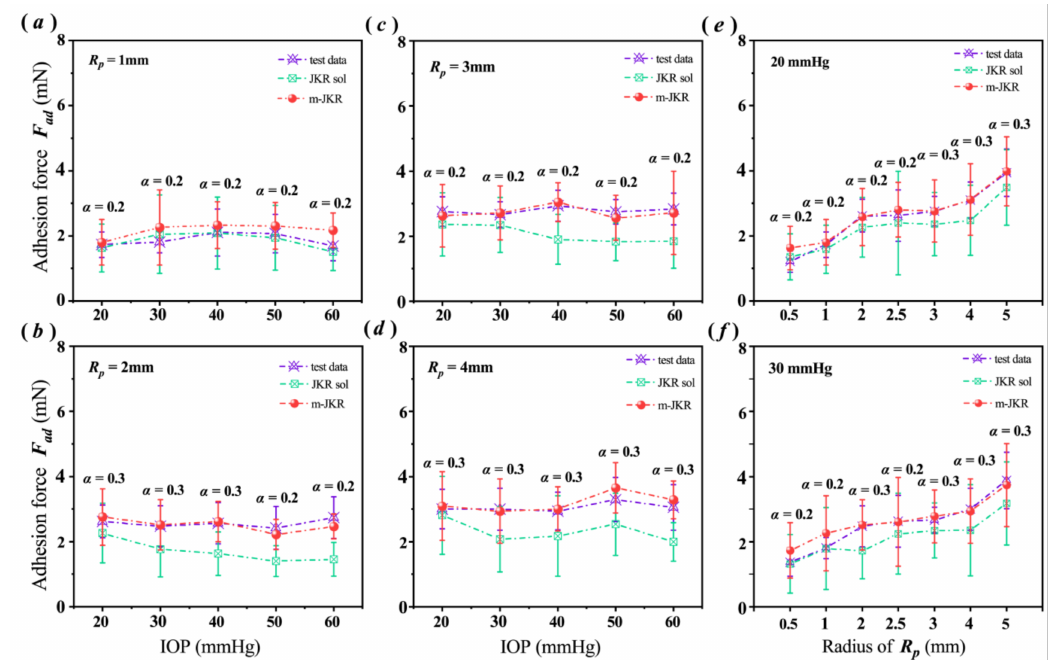
Figure 4. Comparisons of the corneal adhesion force, F ad , obtained from the experiment and theories: ( a – d ) show comparisons of the different IOPs; ( e , f ) show comparisons of the scale effect of the corneal adhesion under the normal IOPs of 20 and 30 mmHg. The data are presented as the mean ± SD; JKR sol and m-JKR indicate the solutions from the JKR and modified JKR models,